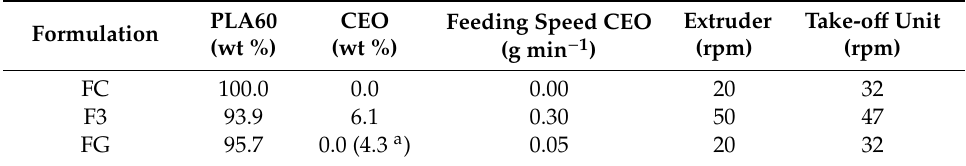
Table 2. Formulations for the preparation of the bio-based polymeric fibers, feeding speed for cinnamon essential oil (CEO), extruder, and take-o ff unit